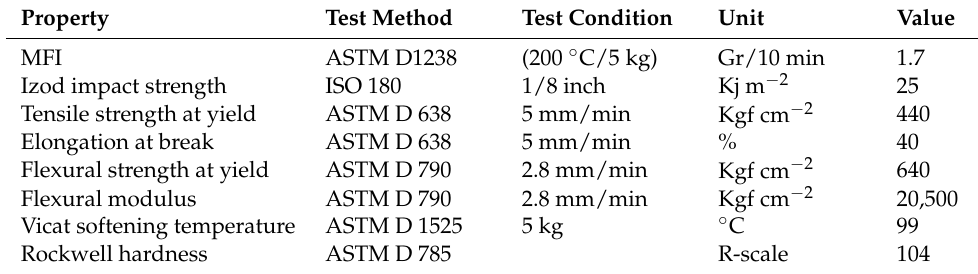
Table 1. Key properties of SD-0150-grade ABS [17].